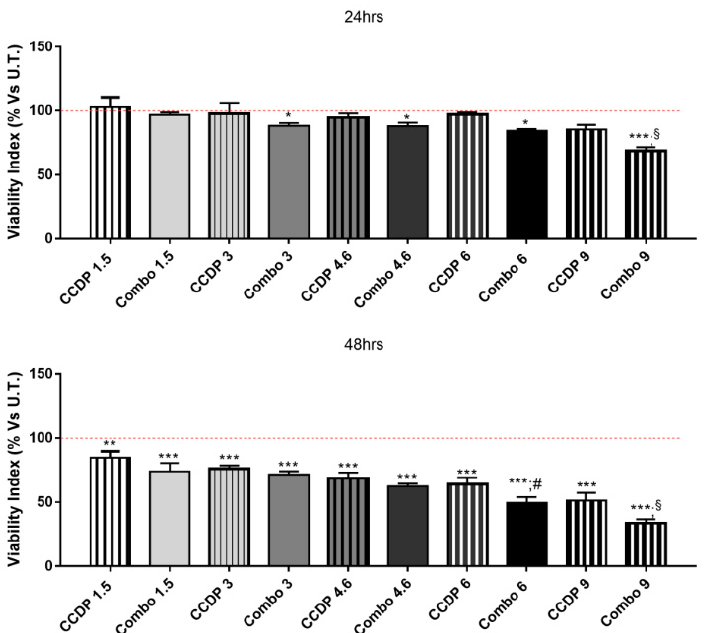
Figure 2. DLD-1 viability index. Viability indices of untreated and treated DLD-1 were analyzed via MTT assay after 24 and 48 h. The data are expressed as percentages vs. viability index of untreated DLD-1 (represented in the graphs as the red dotted line), and each value represents the mean ± SD of 3 separate experiments running in triplicate. The CCDP concentrations are expressed as μ g/mL; Combo units are in µ g/mL of CCDP and mg/mL of NK600 in each Combo.*** p < 0.001; ** p < 0.01; * p < 0.05 vs. untreated DLD1; § p < 0.001; # p < 0.01 vs. CCDP alone, untreated DLD1 (one-way ANOVA).